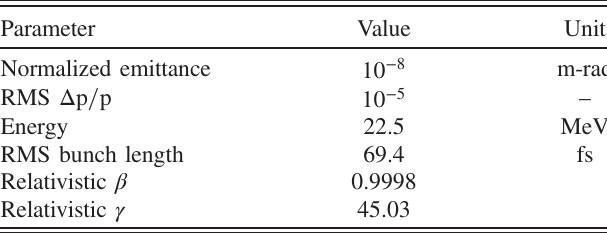
TABLE V. General electron beam